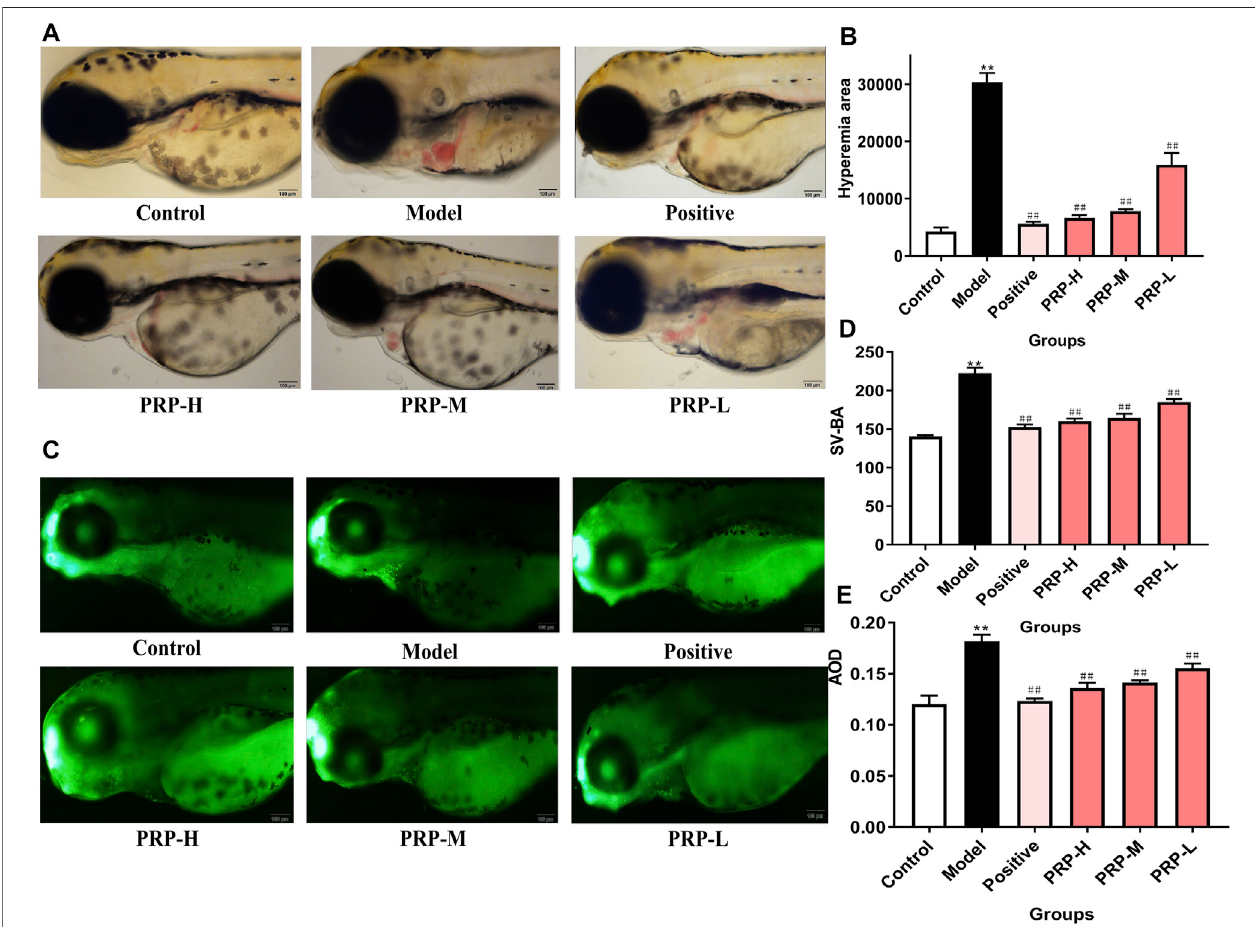
FIGURE 3 | The effect of PRP on the heart development of zebra fi sh embryos following barium chloride treatment. (A) Morphological observations of the heart development of zebra fi sh embryos under a microscope, with the heart shown in the yellow box (X10). (B) The cardiac congestion area of zebra fi sh embryos was calculated. (C) The results of acridine orange staining. The apoptosis of zebra fi sh embryos cardiomyocytes observed under fl uorescence microscopy is shown in the yellow box (X10). (D) The SV-BA distance was measured. (E) The average fl uorescence density was calculated.All data are presented as means ± SD, n (cid:2) 6. * p < 0.05, ** p < 0.01, control versus model; # p < 0.05, ## p < 0.01, model versus positive, PRP-H, PRP-M, and